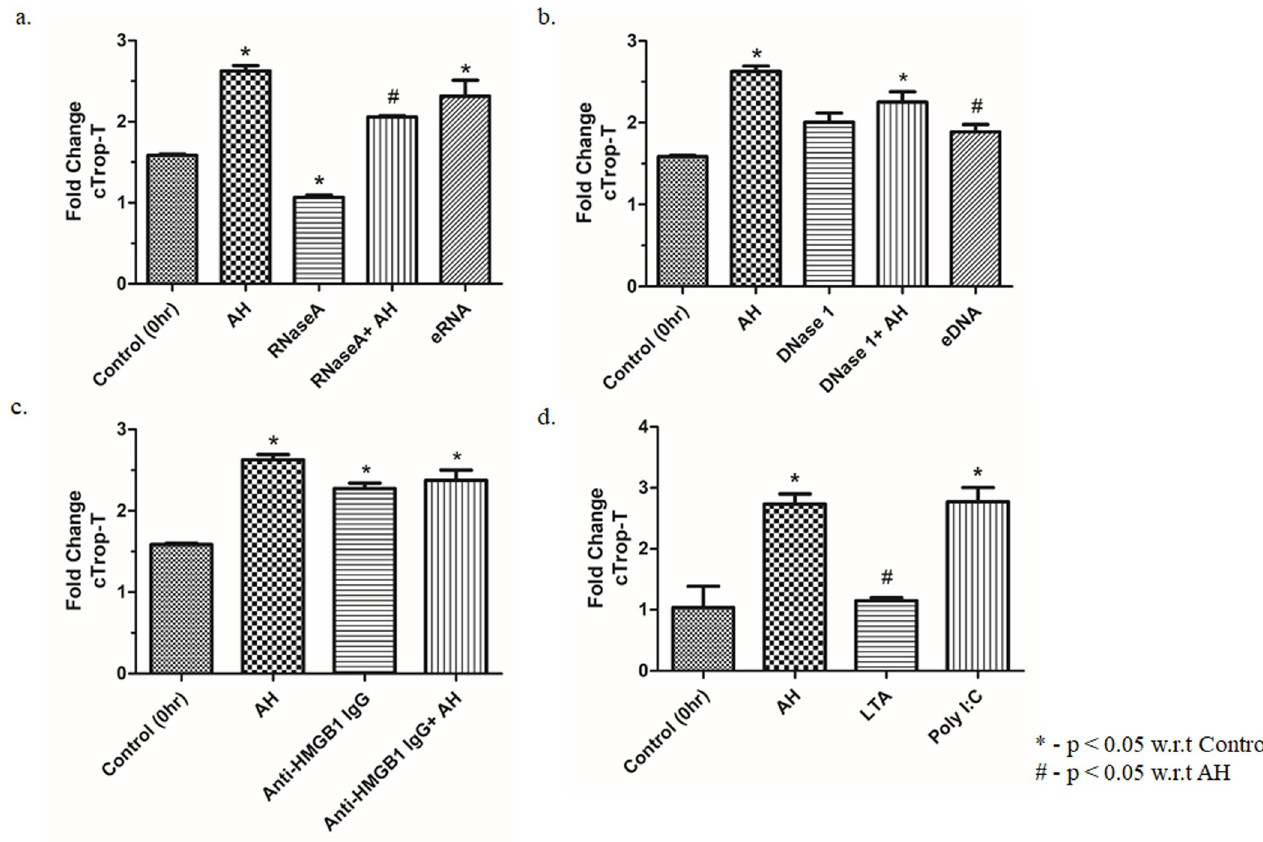
Fig 3. eRNA is involved in hypoxia induced expression of cTrop-T. ELISA estimation of circulating cTrop-T in plasma was done after (a) eRNA injection (80 μ g/kg BW; 6 hrs prior to AH exposure) and RNaseA pre-treatment (1mg/kg BW; 2 hrs prior to AH exposure), (b) eDNA injection (80 μ g/kg BW; 6 hrs prior to AH exposure) and DNase1 pre-treatment (5 mg/kg BW; 2 hrs prior to AH exposure), (c) HMGB1 IgG pre-treatment (200 μ g/kg BW; 2 hrs prior to AH exposure), (d) pre-treatment with LTA (TLR2 agonist, 100 μ g/kg BW; 2 hrs prior to AH exposure) and Poly I:C (TLR3 agonist, 1 mg/kg BW; 2 hrs prior to AH exposure). Control treatment with eRNA, eDNA, RNaseA, DNase 1, HMGB1 IgG, LTA and Poly I:C were done 6 hrs prior to sacrifice and the duration of AH exposure after different treatments was also 6 hrs. Data are shown as mean ± SEM (n = 5/group/treatment) from one experiment representative of three independent experiments, all performed in triplicate. One-way ANOVA revealed statistical significance in the results ( � p < 0.05 groups w.r.t control; #p < 0.05 groups w.r.t